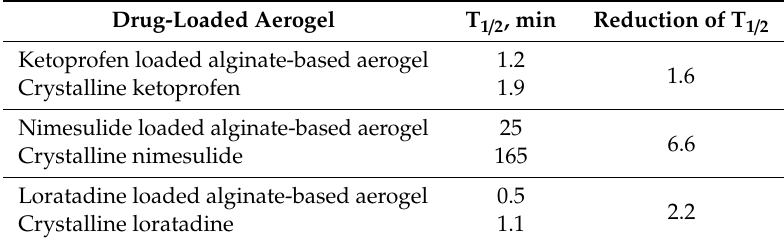
Table 4. Results of in vitro dissolution